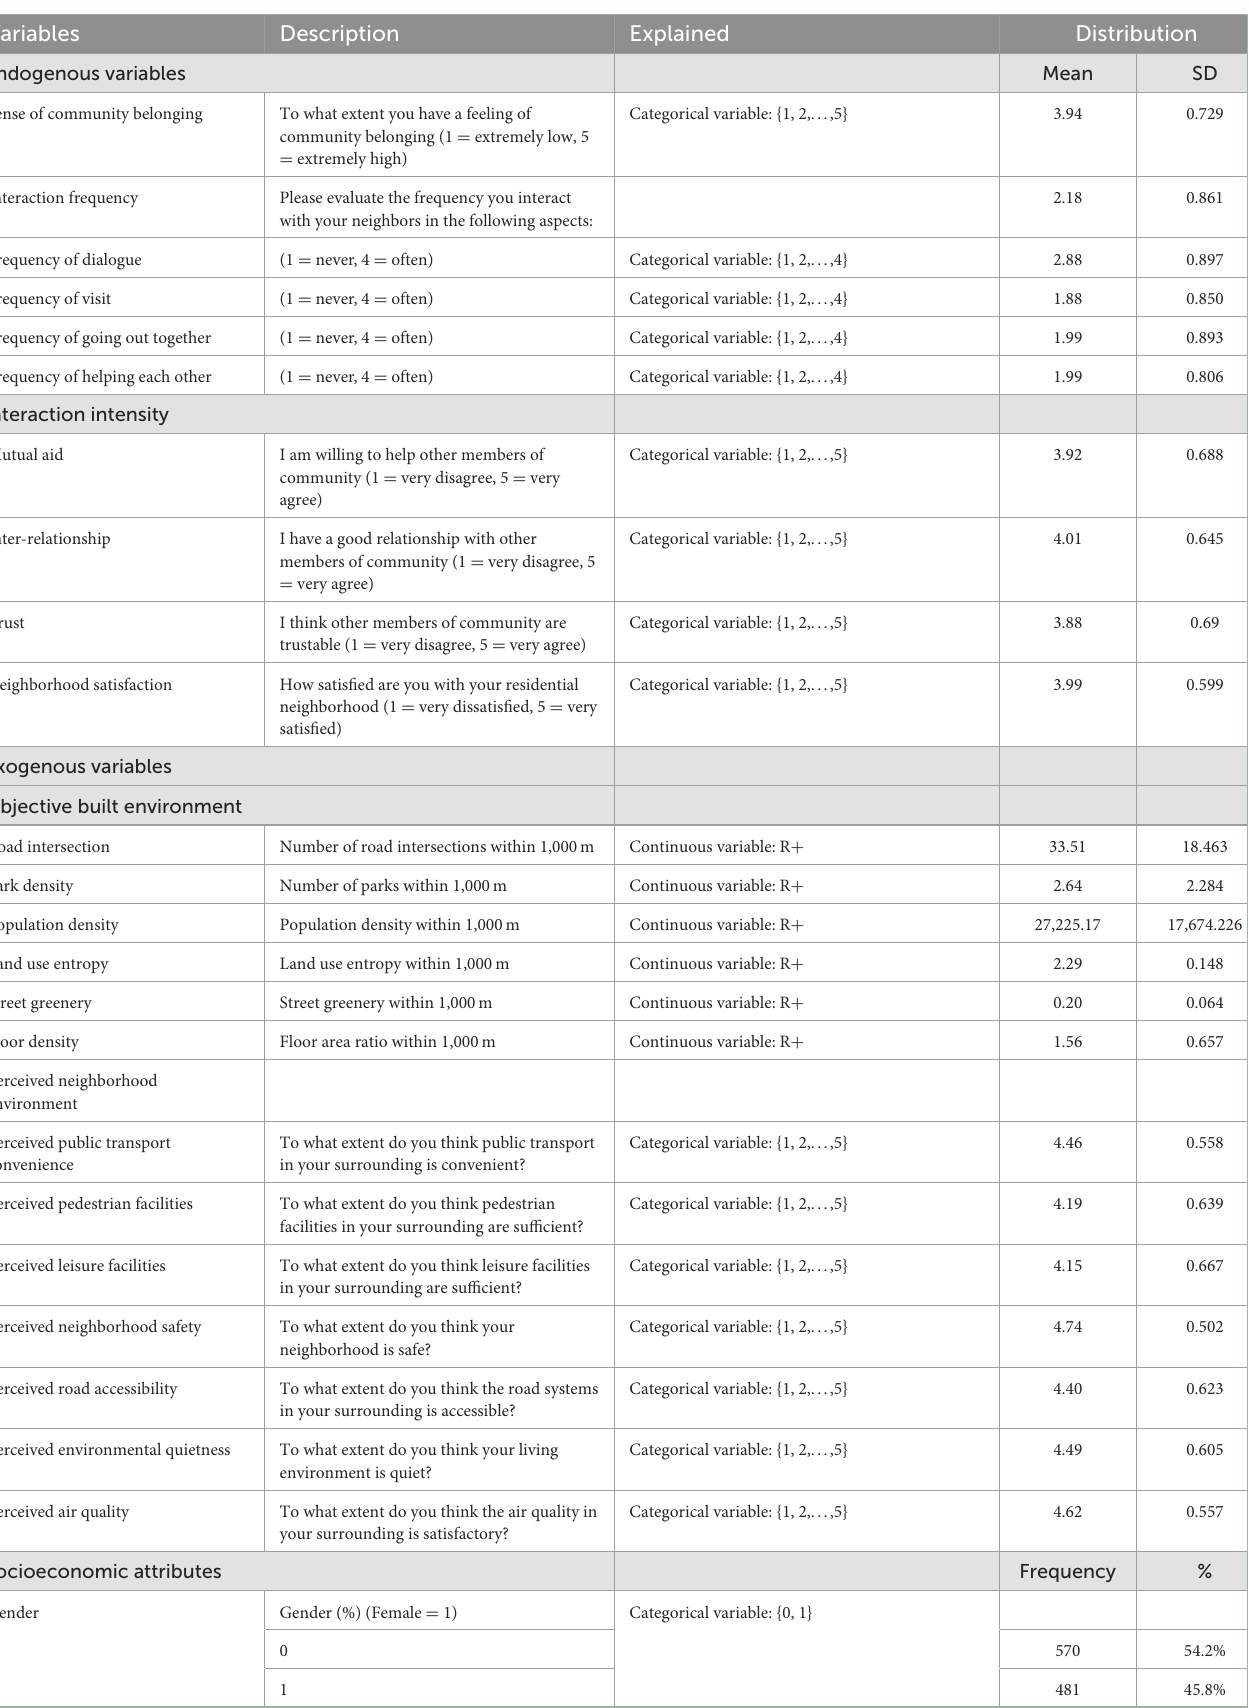
TABLE 1 Explanations of variables and descriptive statistics ( N = 1,051). Variables Description Explained